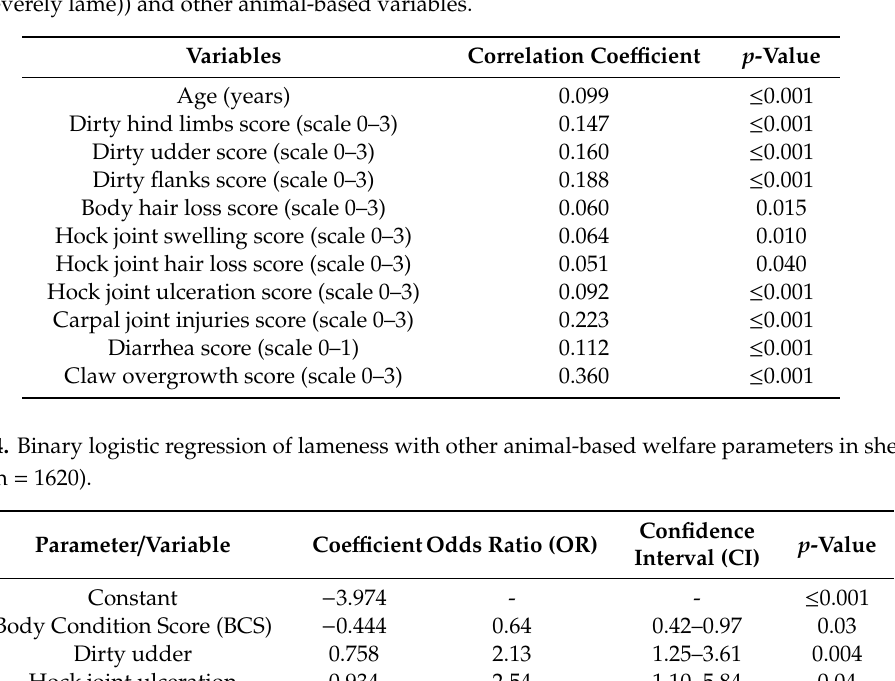
Table 3. Significant ( p < 0.05) Spearman’s rank correlations between lameness (scores from 1 (not lame) to 5 (severely lame)) and other animal-based variables.